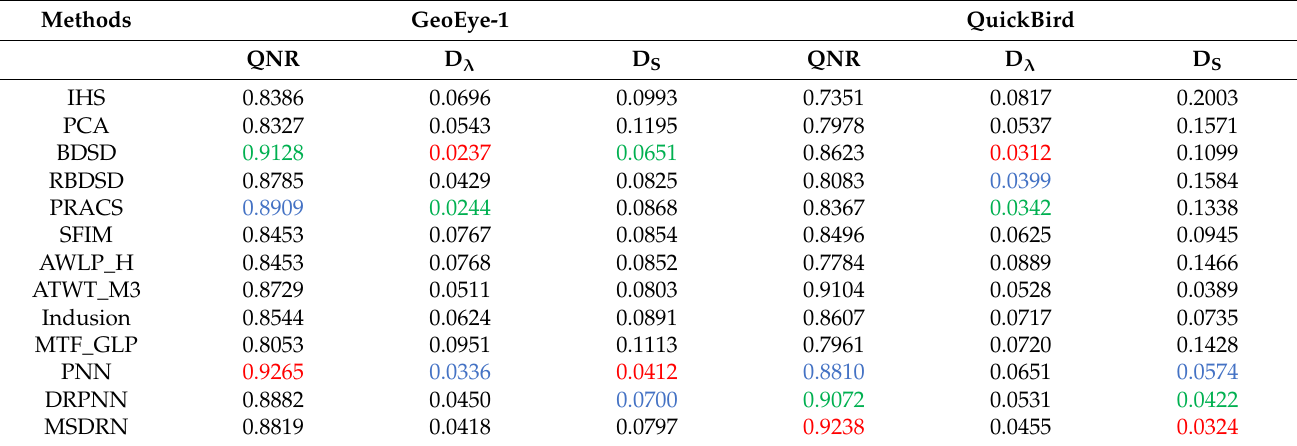
In the table, the top three values of indictors are marked with red, green and blue colors,